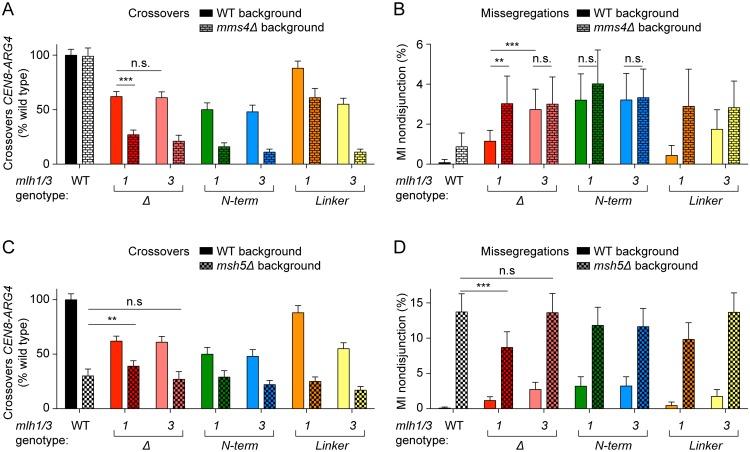
Effects on meiotic recombination of MutLγ mutations in mms4Δ and msh5Δ backgrounds.Crossover levels within the CEN8-ARG4 interval and chromosome VIII MI nondisjunction frequencies were measured by the fluorescent spore assay. The data of MutLγ mutants in a wild-type background are reproduced from Fig 4 to facilitate comparison. The mlh1 and mlh3 mutants assayed were: mlh1-Nterm (K286E/R289E), mlh3-Nterm (K316E/K320E/R323E), mlh1-Link (K393E/R394E) mlh3-Link (K414E/K416E). A. Crossover levels of MutLγ mutants in wild-type and mms4Δ backgrounds. Error bars represent standard errors. The data were normalized to crossover levels in wild type (11.63 ± 0.63 cM). B. MI nondisjunction frequencies of MutLγ mutants in wild-type and mms4Δ backgrounds. Error bars are 95% confidence intervals of the proportion. C. Crossover levels of MutLγ mutants in wild-type and msh5Δ backgrounds. D. MI nondisjunction frequencies of MutLγ mutants in wild-type and msh5Δ backgrounds. Statistically significant differences are indicated with asterisks (**, p<0.01; ***, p<0.001). Selected non-significant differences are highlighted (n.s.).